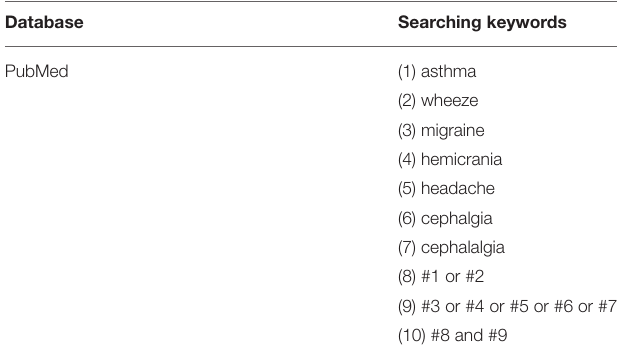
TABLE 1 | The search strategy of PubMed (similar search conducted in other